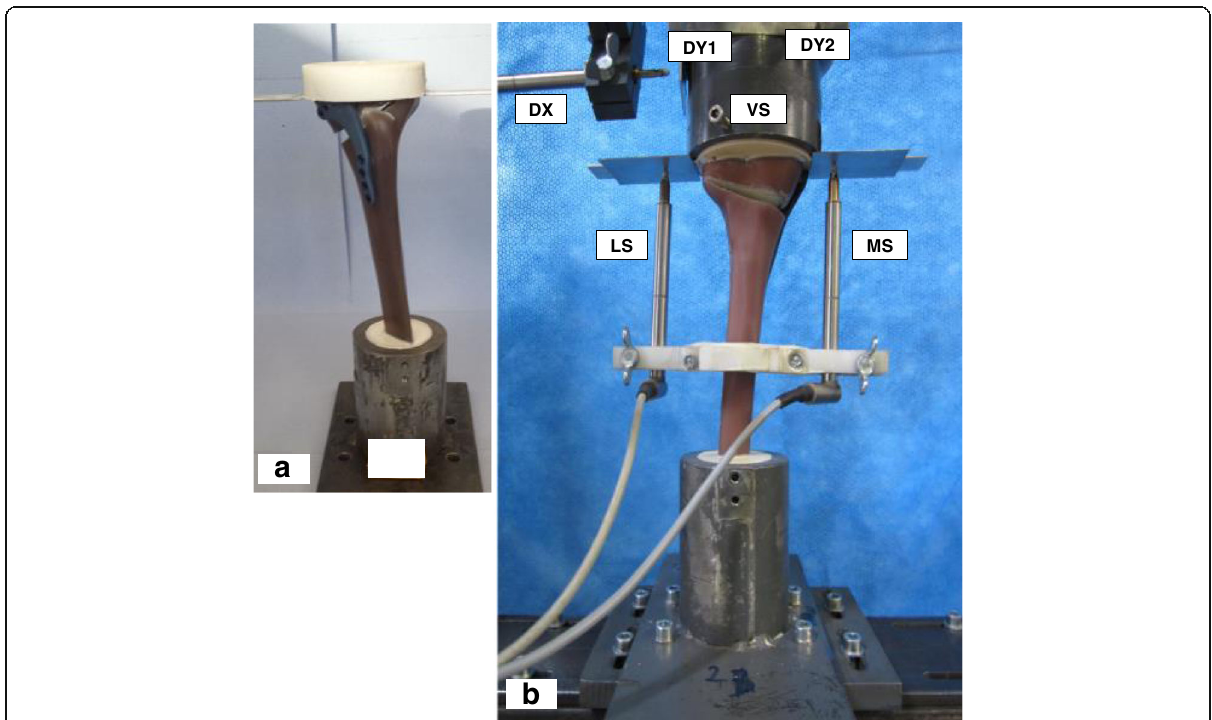
Fig. 1 Specimen and sensors ’ locations: ( a ) Specimen before mounting to hydraulic press. b Specimen under test: The lateral and the medial sensor (LS and MS) register the relative lateral and medial vertical displacements from the tibial head, while VS measured its vertical displacement. The sensors DX, DY1 and DY2 register the horizontal displacements of the tibial head; along the transverse axis for the first and the sagittal axis for the latter